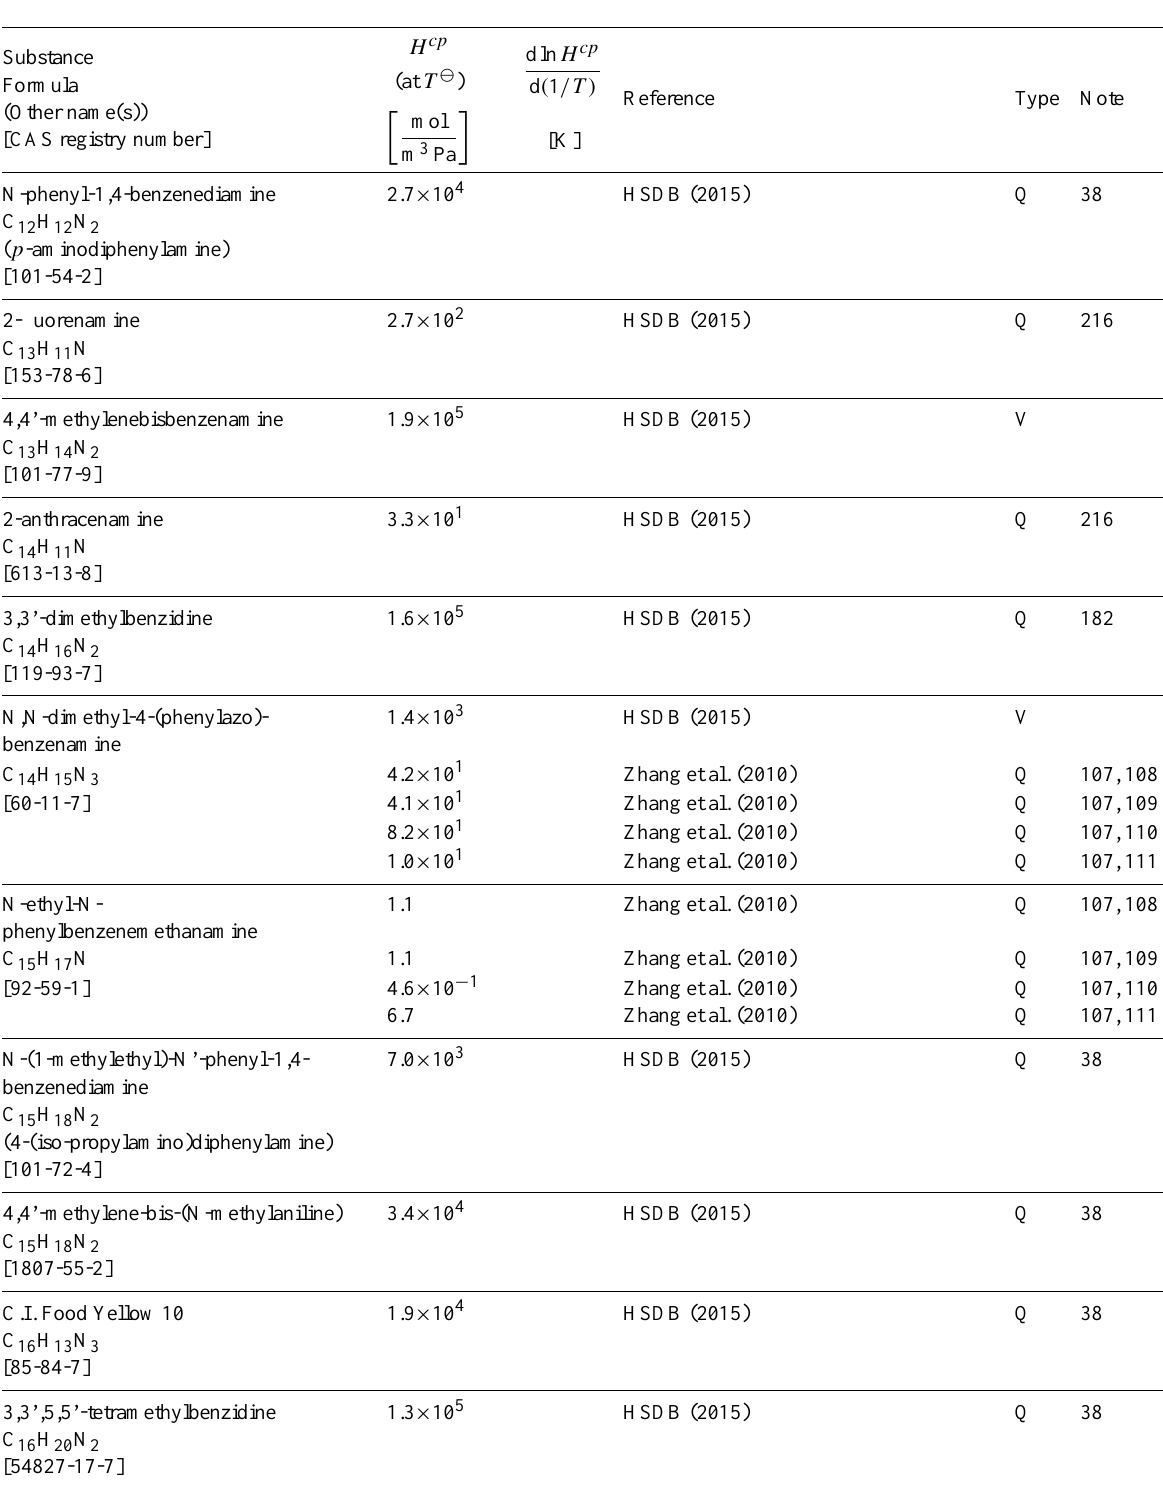
Table 6: Henry’s law constants for water as solvent